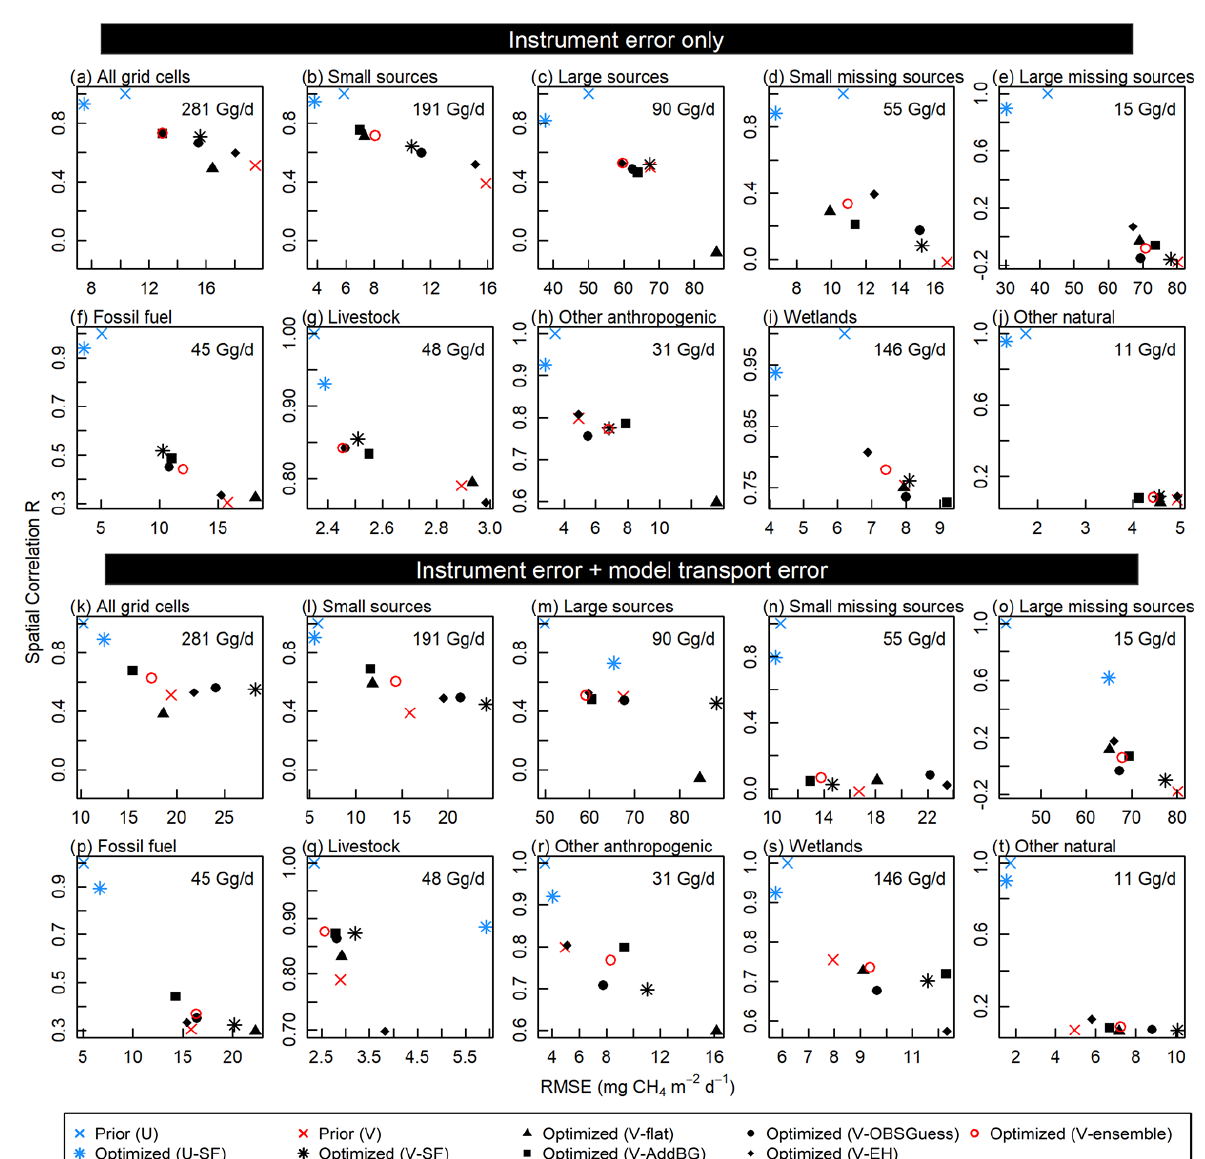
Figure 5. Inversion performance by source size and sector in terms of root-mean-square error (RMSE) and spatial correlation coefficient ( R ) relative to the true fluxes. Results from base-case inversions (instrument error only) are shown for (a) all grid cells, (b) small sources ( < 50mgm − 2 d − 1 ), (c) large sources ( ≥ 50mgm − 2 d − 1 ), (d) small missing sources (prior < 10mgm − 2 d − 1 ; truth ∈ [10, 50)mgm − 2 d − 1 ), (e) large missing sources (prior < 10mgm − 2 d − 1 ; truth ≥ 50mgm − 2 d − 1 ), (f) fossil fuel, (g) livestock, (h) other anthropogenic, (i) wetland, and (j) other natural emissions. Panels (k) – (t) show results including model transport error. The total true fluxes are indicated in each